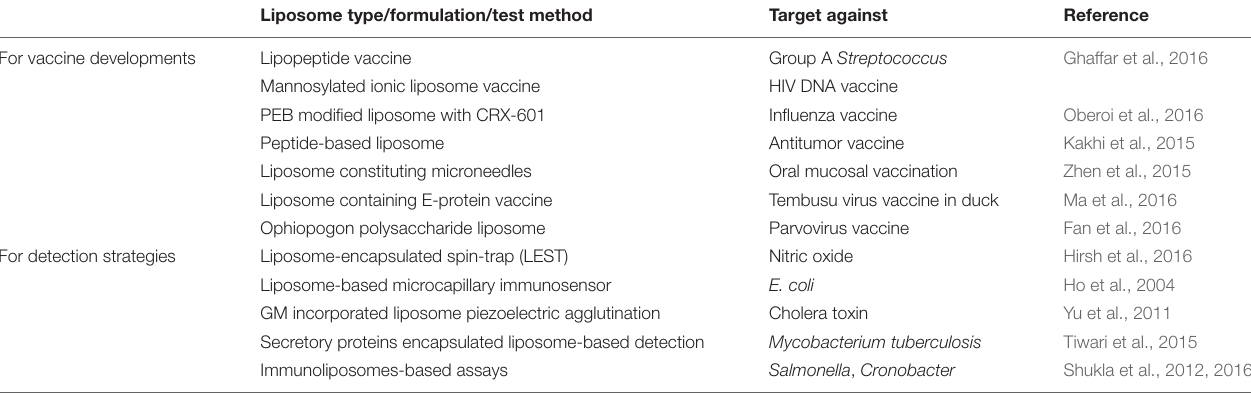
TABLE 2 | Updates on liposome nanoparticles used for vaccine developments and for detection